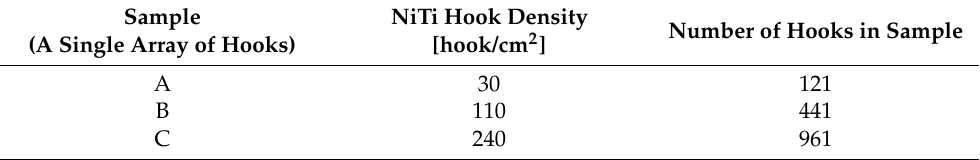
Figure 2. Photograph of a NiTi releasable fastener with the hook array embedded in a rigid matrix. Table 2. NiTi hook samples.